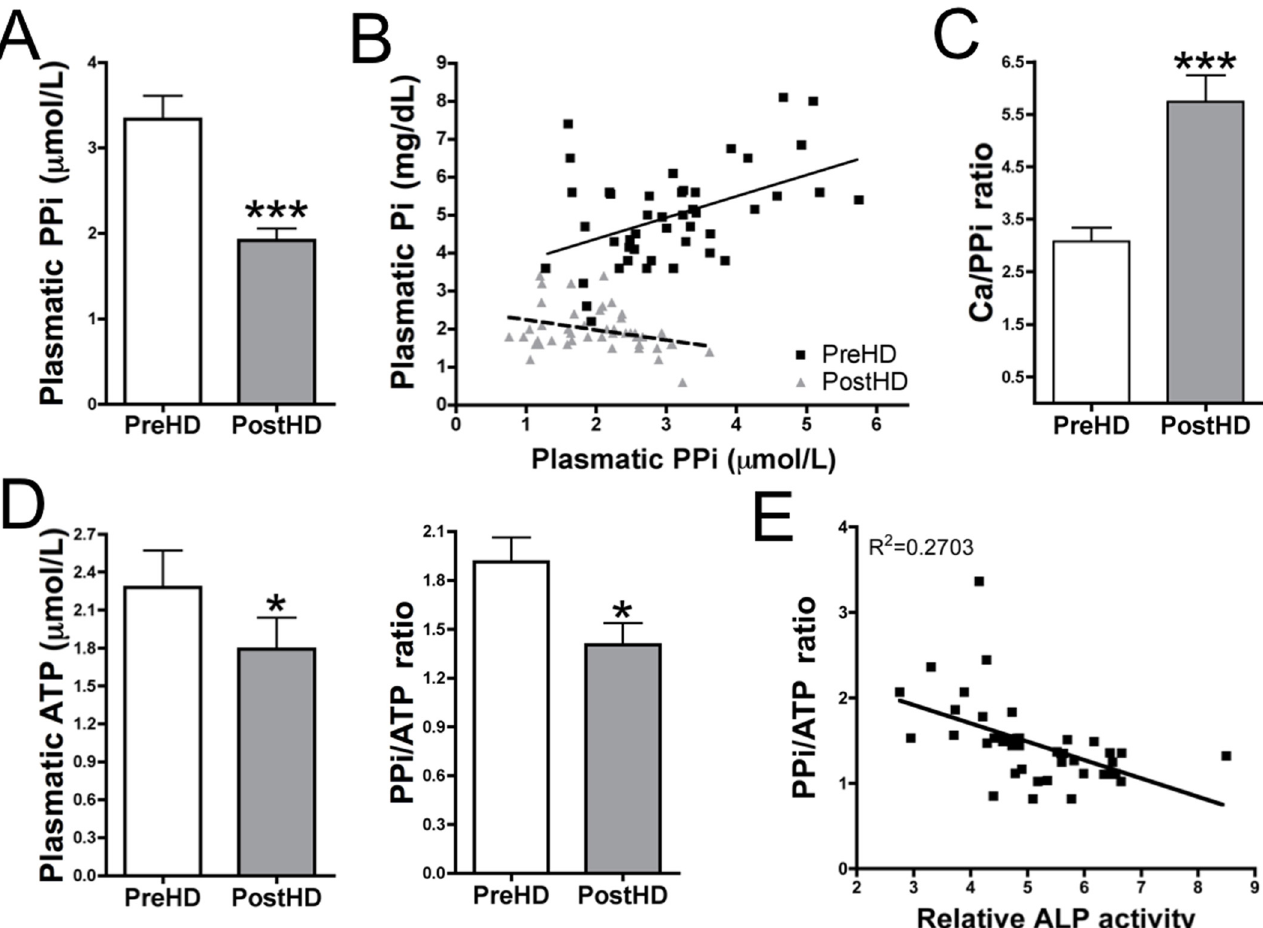
Fig 3. PPi availability is reduced post-hemodialysis. ( A ) Plasma PPi quantification. ( B ) The scattergraph shows a correlation between plasma Pi and PPi. ( C ) Plasma (Ca)/PPi ratio. ( D ) Plasma ATP quantification and PPi/ATP ratio. ( E ) The scattergraph shows a correlation between PPi/ATP ratio and relative ALP activity in PostHD plasma. ( B, E ) A significant deviation was observed using linear regression. ( A, C, D ) Results are represented as mean ± SEM for all paired samples (n = 45). Wilcoxon ’ s matched pairs test was used for statistical analysis. PPi, pyrophosphate; Pi, phosphate; Ca, calcium; ALP, alkaline phosphatase; PreHD, pre-hemodialysis; PostHD, post-hemodialysis. * P < 0.05; *** P < 0.001 .